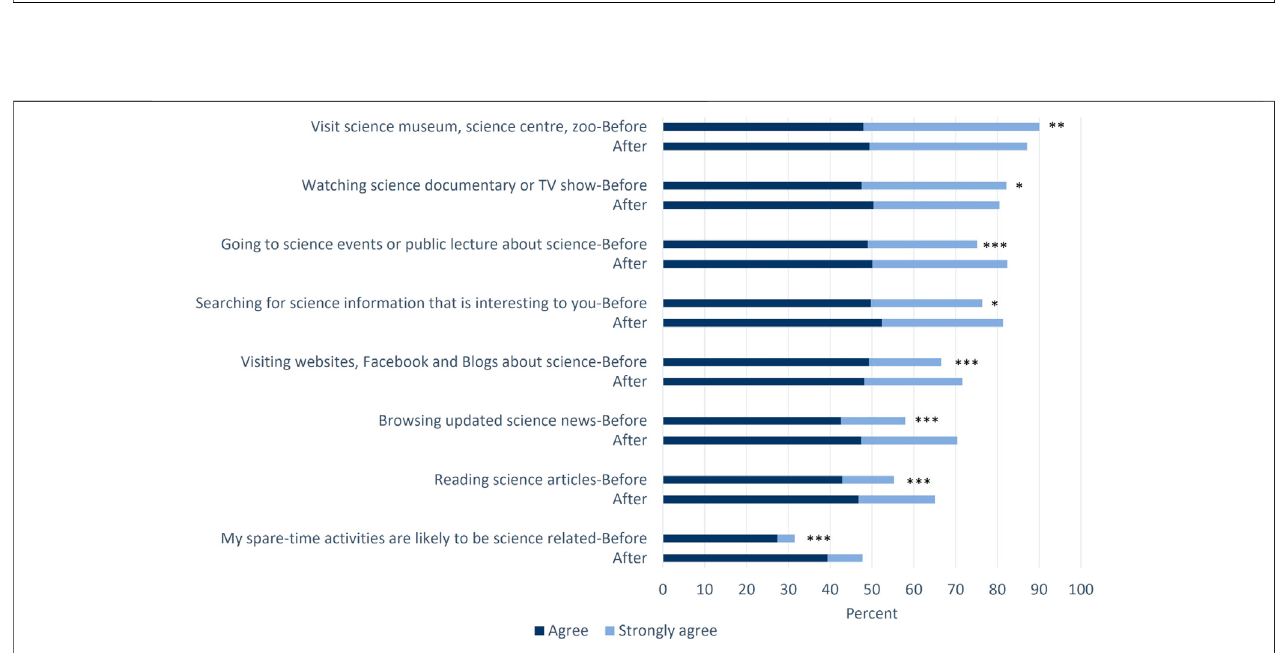
FIGURE 3 | Current female and male presenter responses on four attitude scales before (A) and after (B) presenting. Higher scores indicate more favorable attitudes towards science with the exception of the science anxiety in presenting scale, where higher scores indicate more science anxiety. Independent sample t -tests were conducted to detect signi fi cant differences. N.B.: *p < 0.05 , **p <